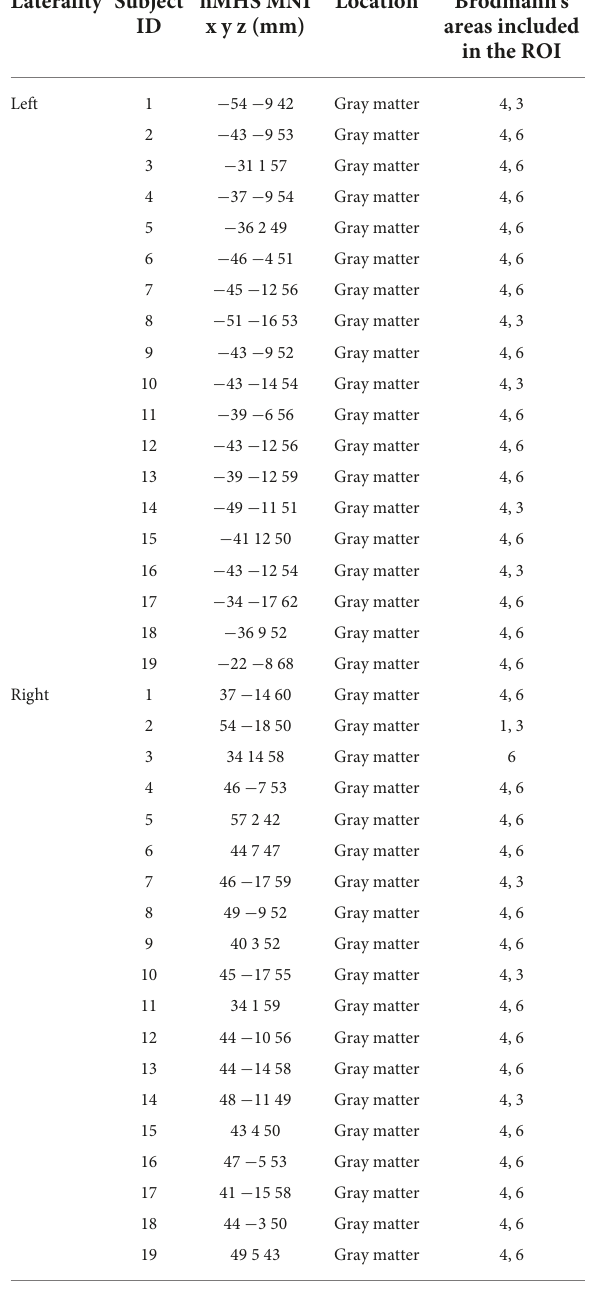
TABLE 1 Description of the ROIs obtained using the individual hand motor hotspot (hMHS): MNI coordinates and corresponding location of the hMHS detected by TMS for each subject in the left and right hemispheres and Brodmann’s areas within each ROI. Laterality Subject